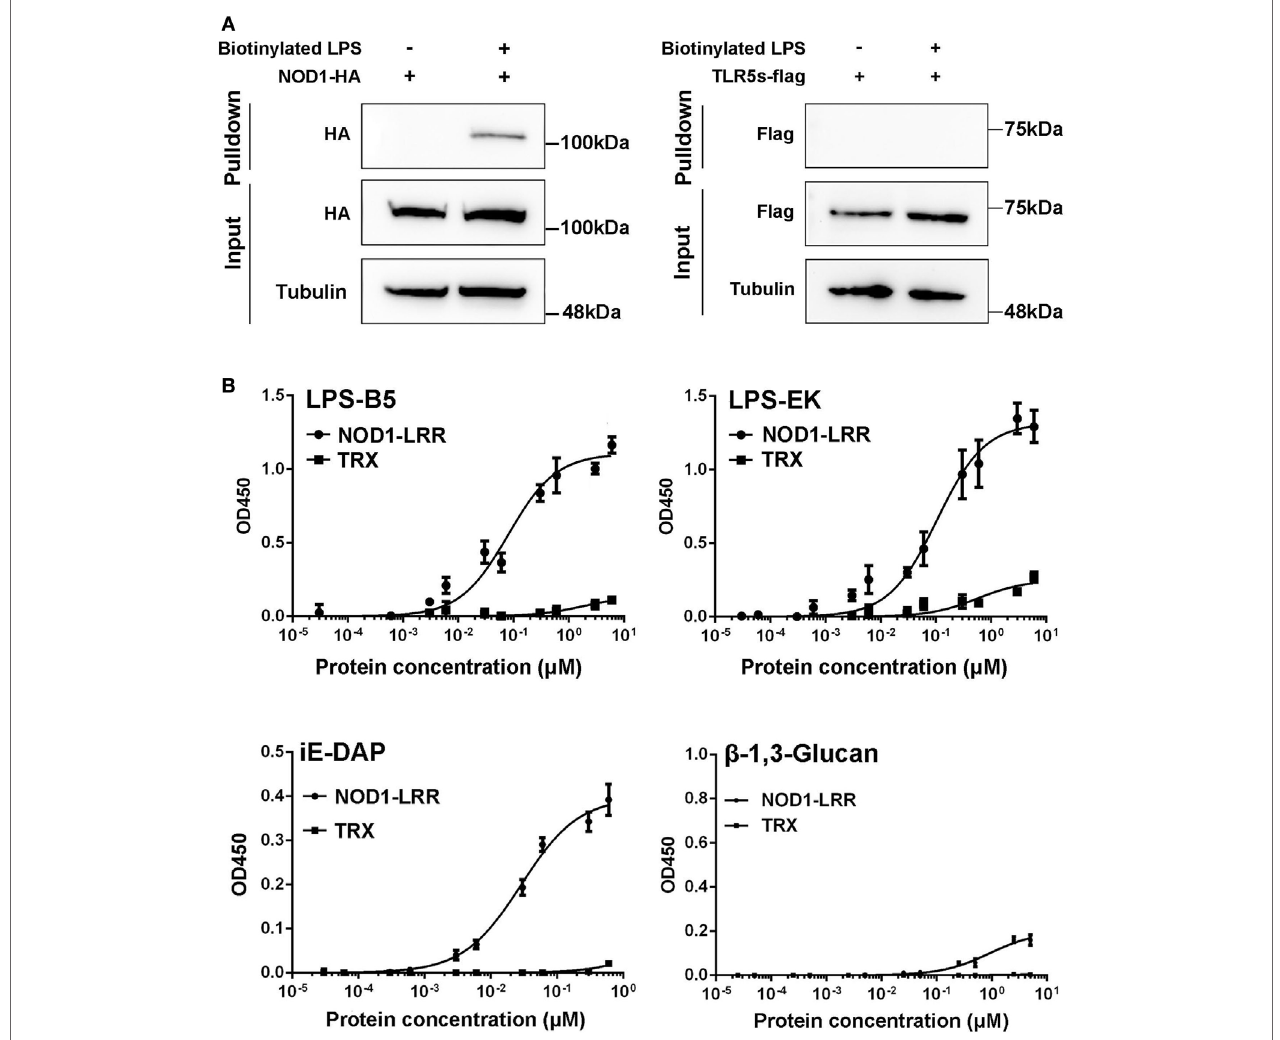
FigUre 5 | Binding activity analysis of NOD1-LRR protein to lipopolysaccharide (LPS) and iE-DAP. (a) Streptavidin pulldown assays of LPS binding to endogenous NOD1 and TLR5s. The cropped HA and Flag blot are shown for pulldown and input, a cropped Tubulin blot is shown for input. For um-cropped blot, see Figures S3A,B in Supplementary Material. (B) Binding activity analysis of miiuy croaker NOD1-LRR and TRX to ultrapure LPS-B5, LPS-EK, iE-DAP, and β -1,3-Glucan by using enzyme-linked immunosorbent assay. For un-cropped NOD1-LRR and TRX blot, see Figure S3C in Supplementary